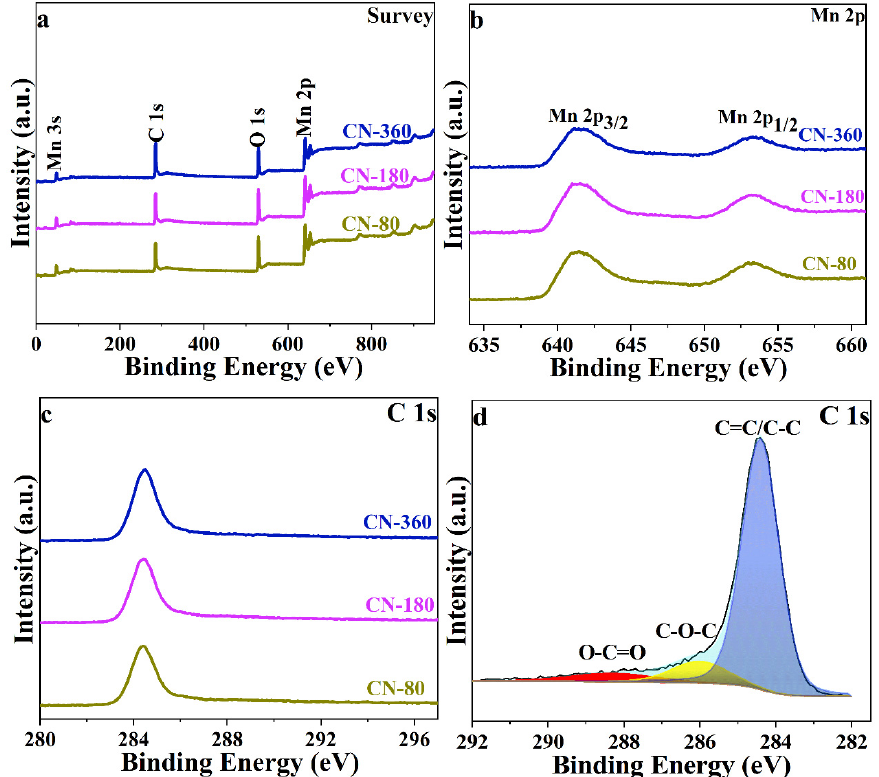
Figure 3. XPS survey spectra ( a ), Mn 2p spectra ( b ), C 1s spectra ( c ) of MC-80, MC-180, and MC-360, and C 1s spectrum of MC-180 ( d ).